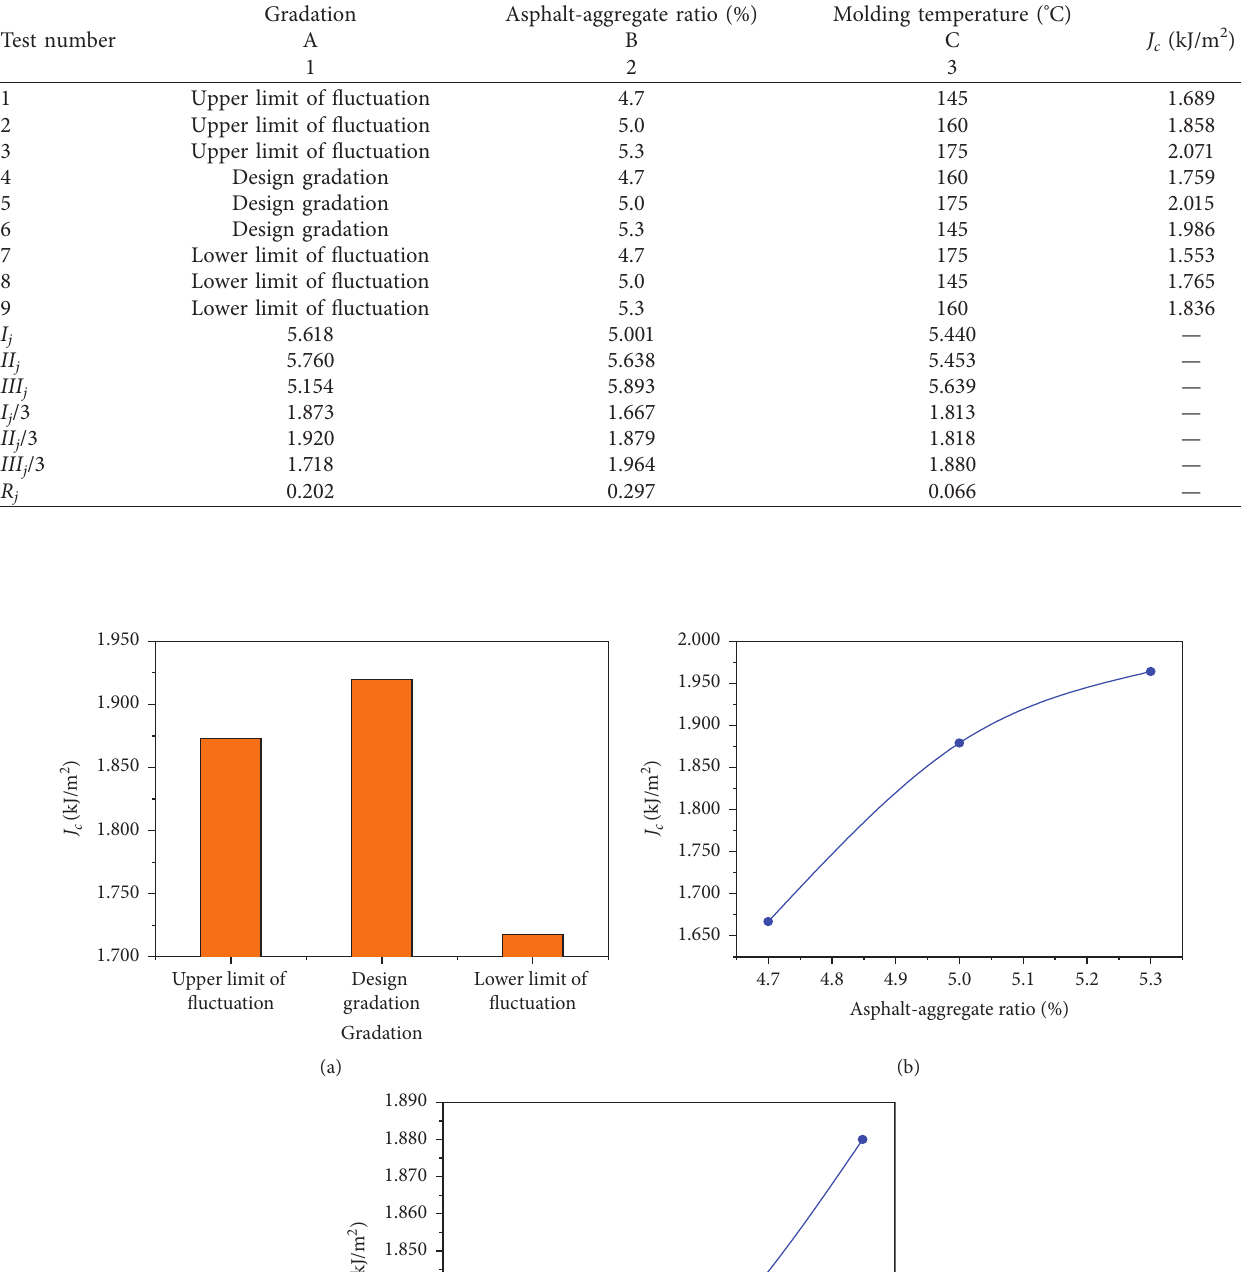
Table 10: OT results and range analysis.